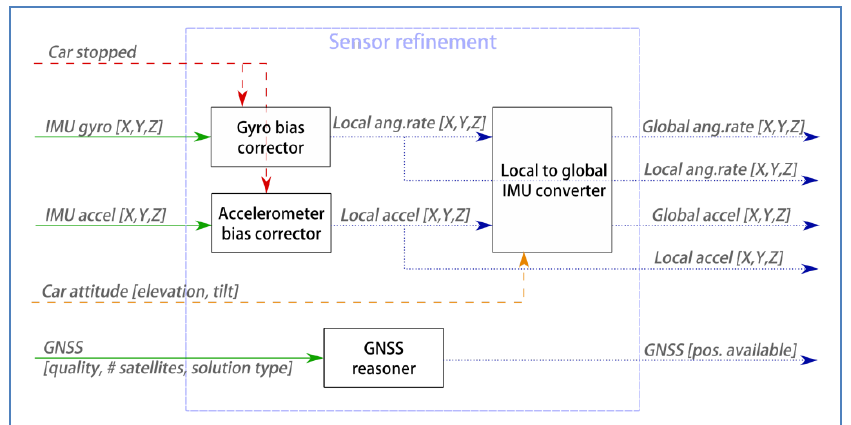
Figure 10. Sensor refinement